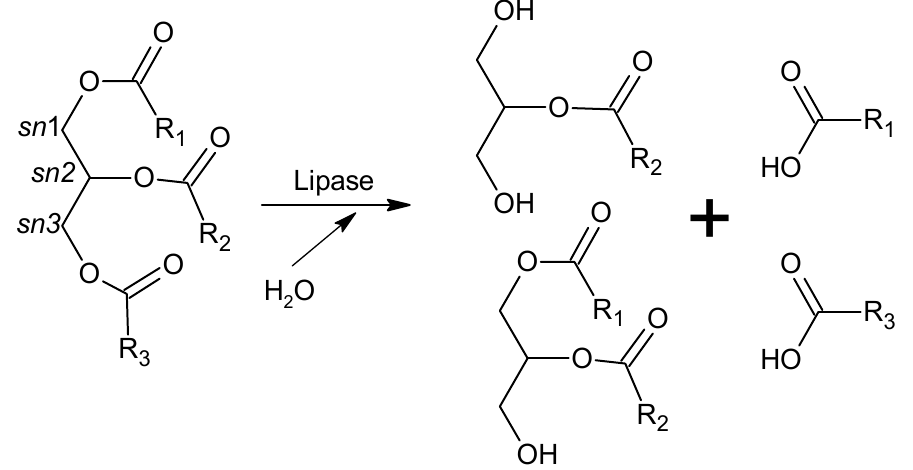
Figure 1. Hydrolysis of triglyceride by lipase activity. R 1 , R 2 , and R 3 are fatty acid residues.